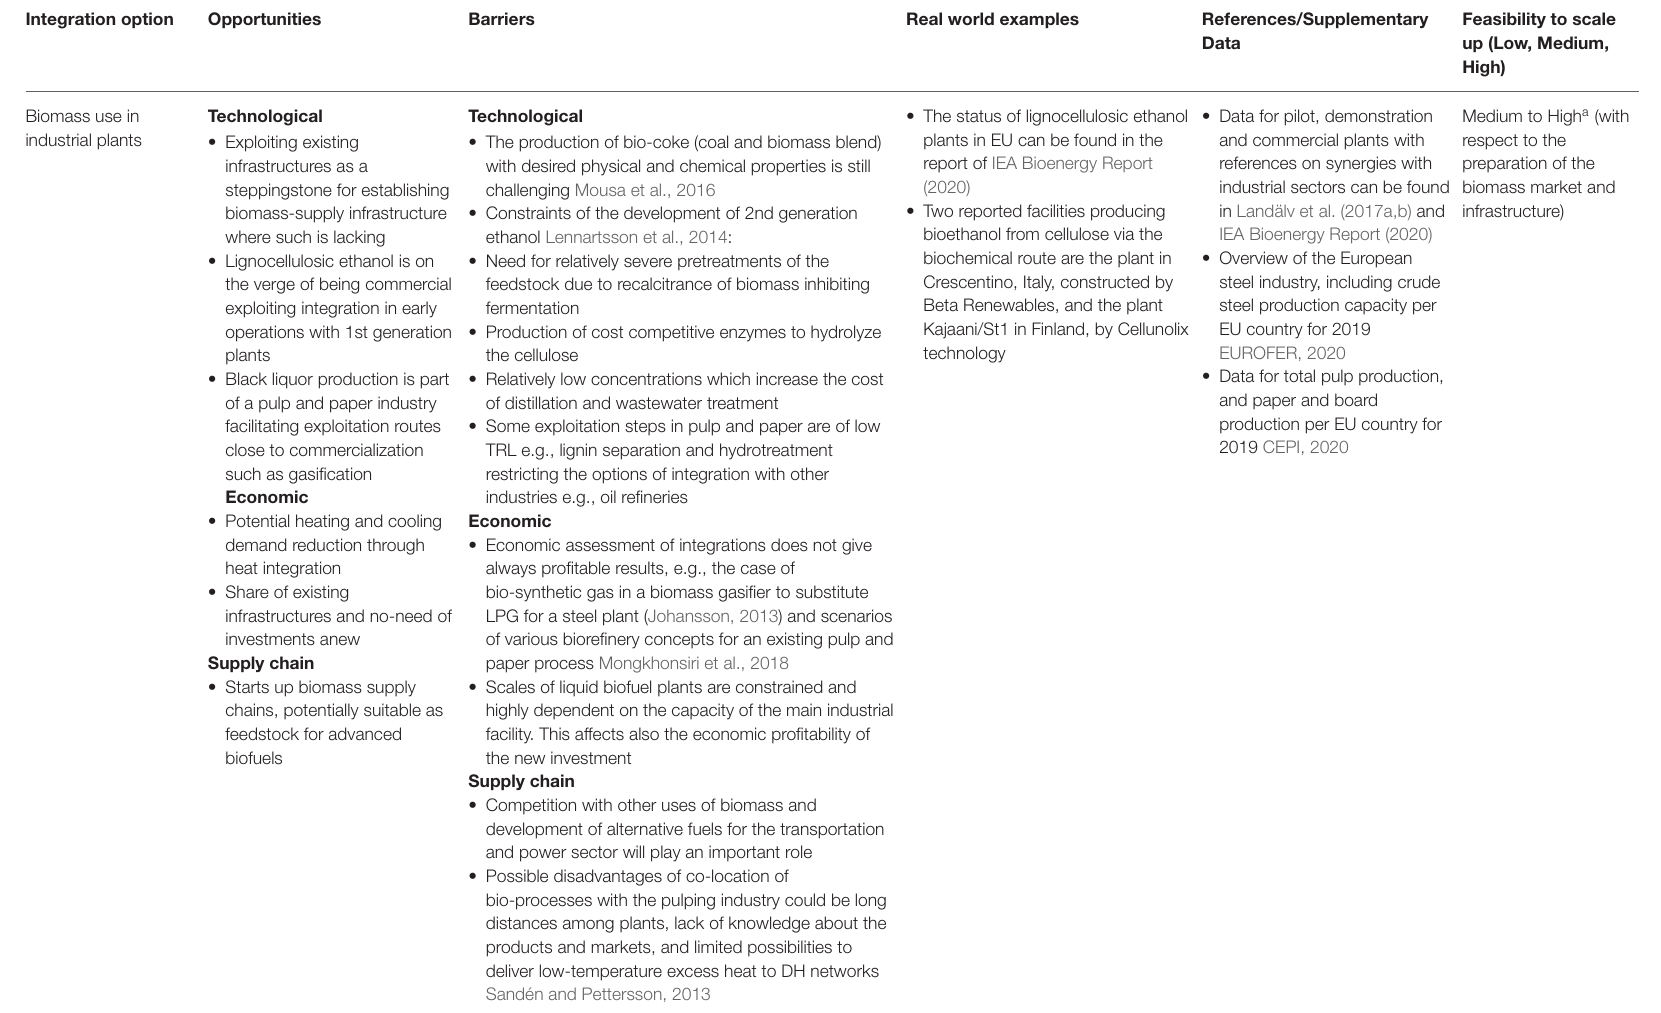
TABLE 3 | Indirect integrated options of biomass use in processing